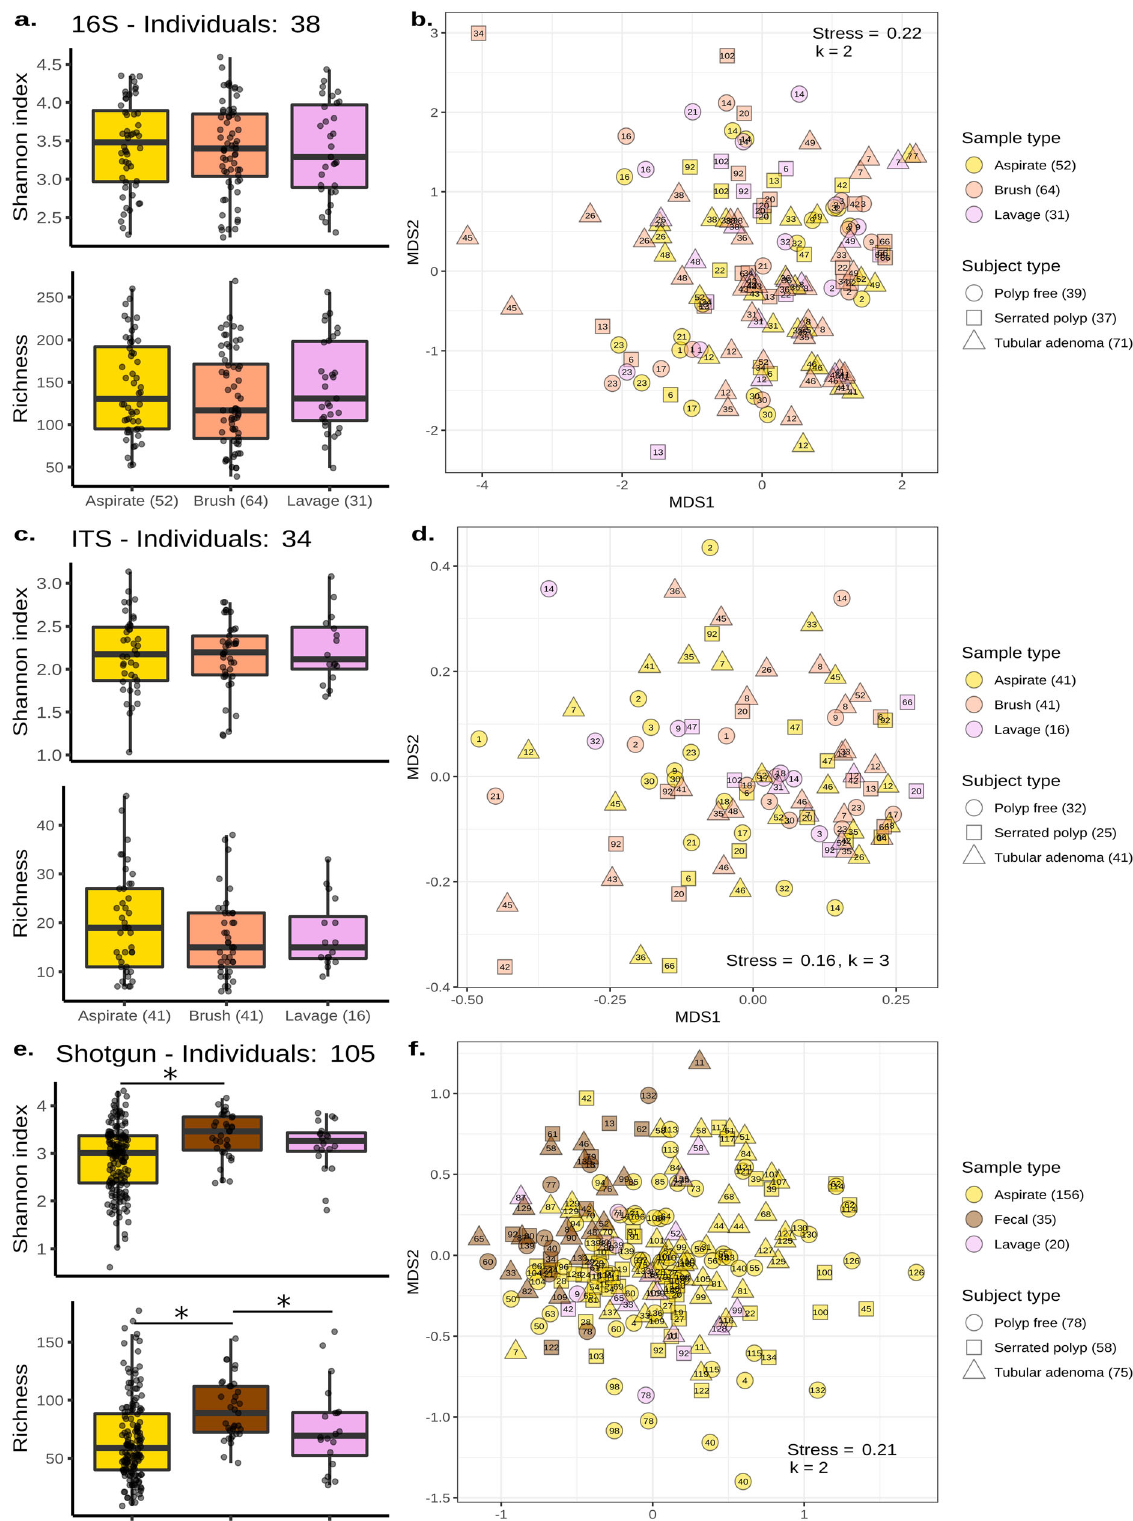
UBA7182 HGM12585 were the top microbes of importance for the SP-bearing versus TA-bearing RF classi fi cation (Fig. 4e). Figure 4f displays the relative abundances for the top variables of importance in all RF